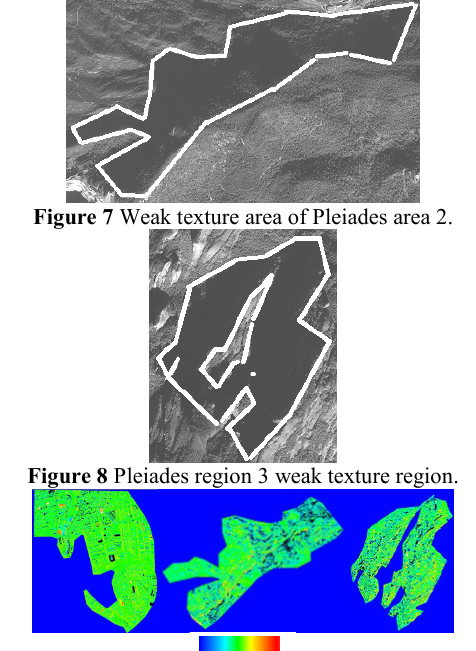
Figure 7 Weak texture area of Pleiades area 2.